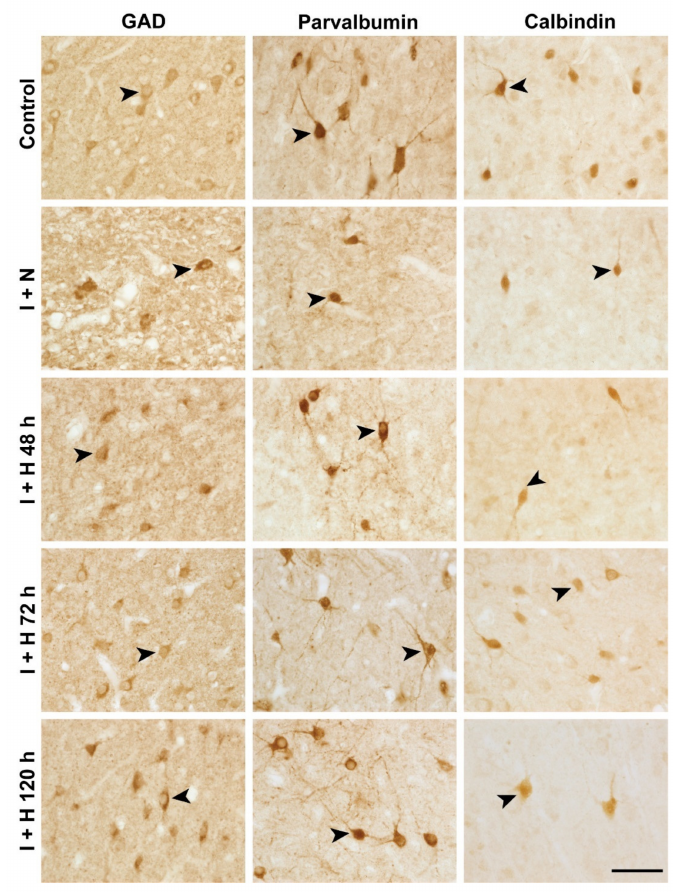
Figure 2. Photomicrographs of glutamate decarboxylase (GAD) + , parvalbumin + , and calbindin + cortical interneurons in sham control, cerebral ischemia + normothermia (I + N), cerebral